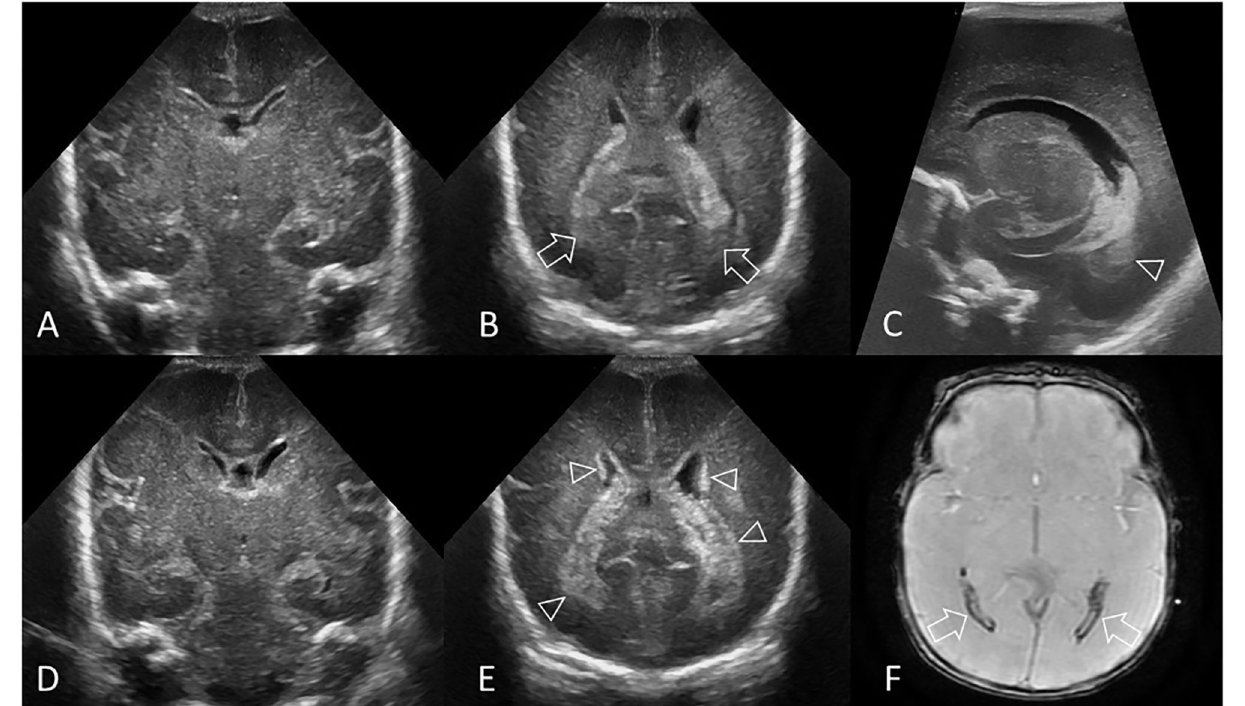
Frontiers in Pediatrics |